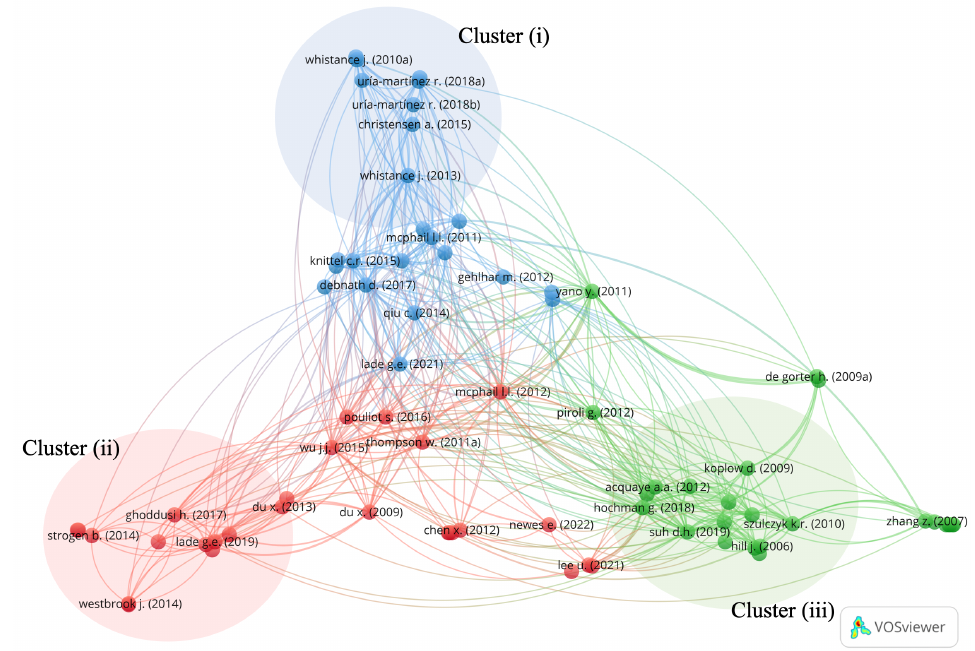
Figure 13. Predominant clusters identified through bibliographic